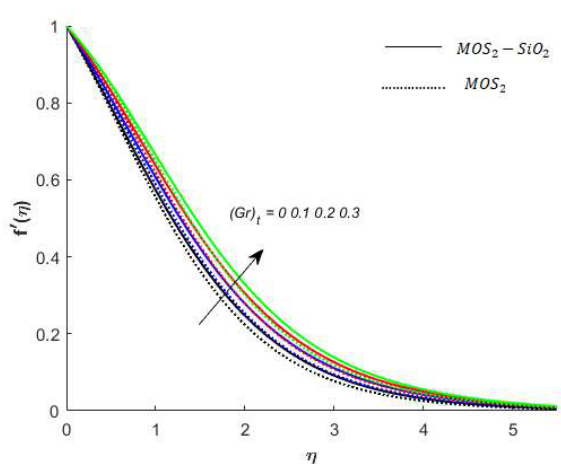
Figure 4. Variation in velocity for (𝐺𝑟) (cid:3047) when 𝑀 = 0.2, 𝑃𝑟 = 2.36,𝐸𝑐 = 0.01,𝑆𝑐 = 0.8,𝑆𝑟 = 0.1,𝐾 = 0.1,𝐵𝑖 = 0.05,and 𝛽 ∗ = 0.1 .